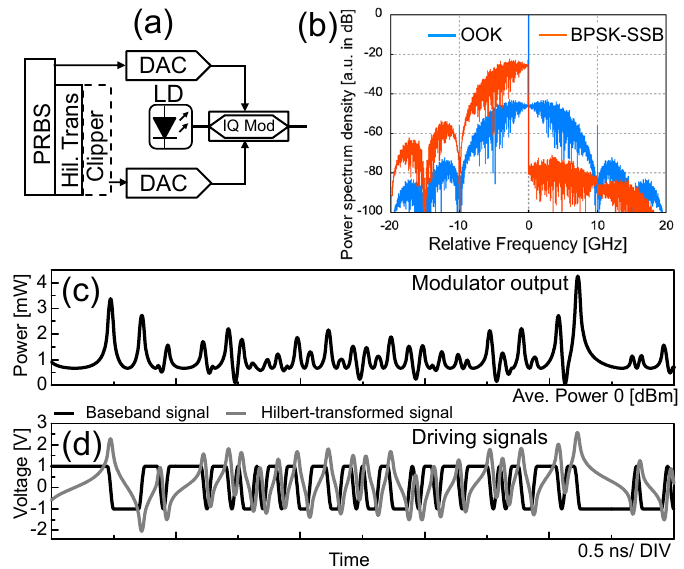
Figure 1. ( a ) IQ modulator based OSSB-SC transmitter; ( b ) spectra of optical BPSK-SSB signal and OOK modulated signal; ( c ) temporal waveform of optical BPSK-SSB modulator output power; ( d ) temporal waveforms of modulator driving signals, PRBS: pseudo-random binary sequence generator, DAC: digital-to-analog converter, OOK: on-off keying, BPSK-SSB: binary phase-shift keying-single sideband.